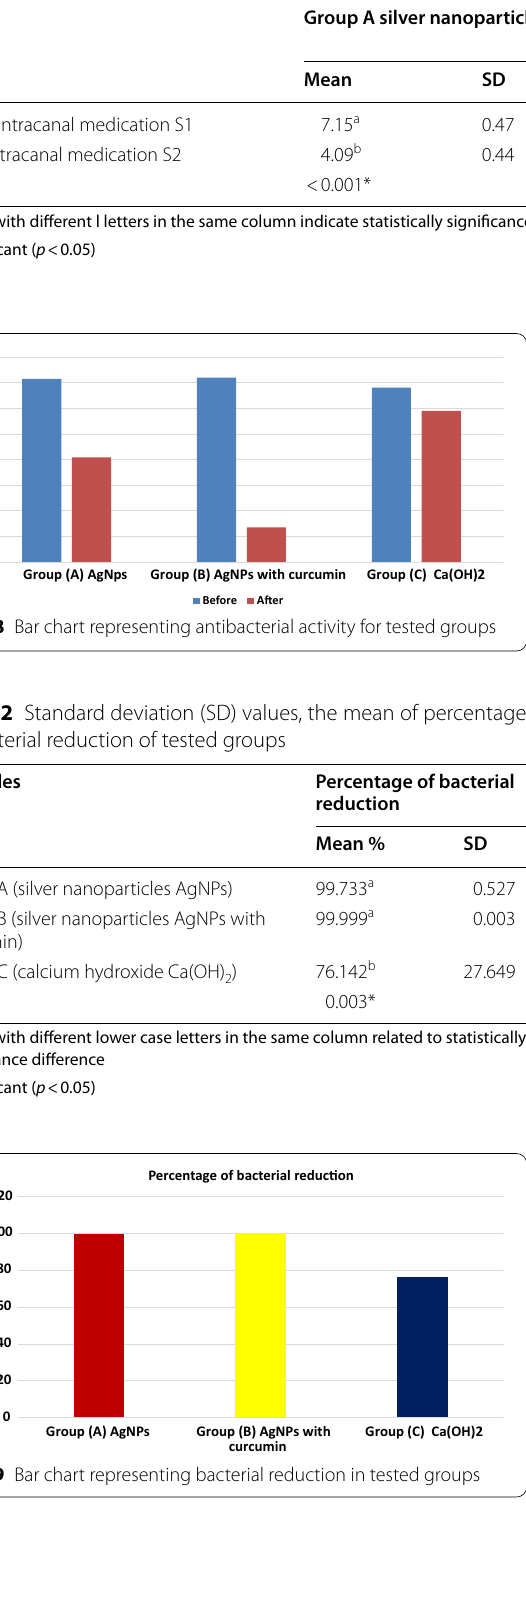
Table 1 Standard deviation (SD) values, the mean of LOG 10 of bacterial number of tested groups